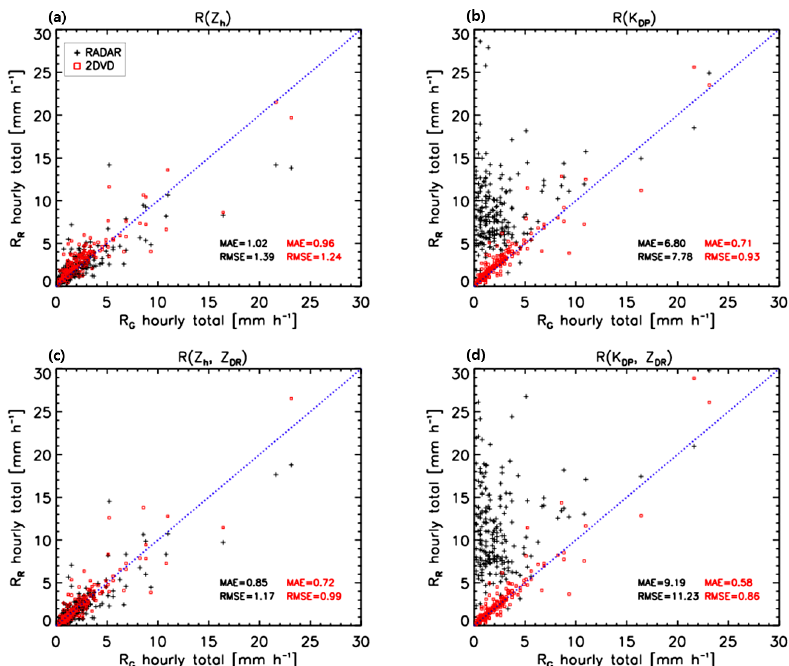
Figure 7. Scatter plot of the 1h rain rate from rain gauge ( R G ) and BSL S-band radar (or 2DVD) based on Eq. (4) for 18 rainfall cases. The pluses represents 1h gauge rain rates vs. radar hourly rain rates from polarimetric rainfall algorithms, and squares indicate gauge and 2DVD rain rates obtained by different polarimetric rainfall algorithms.